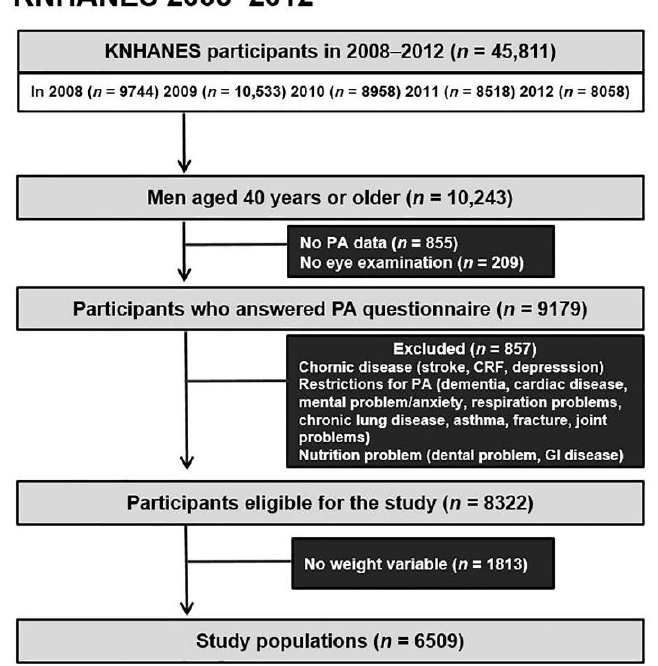
Figure 1. Flowchart of the study population. CRF, chronic renal failure; GI, gastrointestinal; KNHANES, Korea National Health and Nutrition Examination Survey; PA, physical activity.